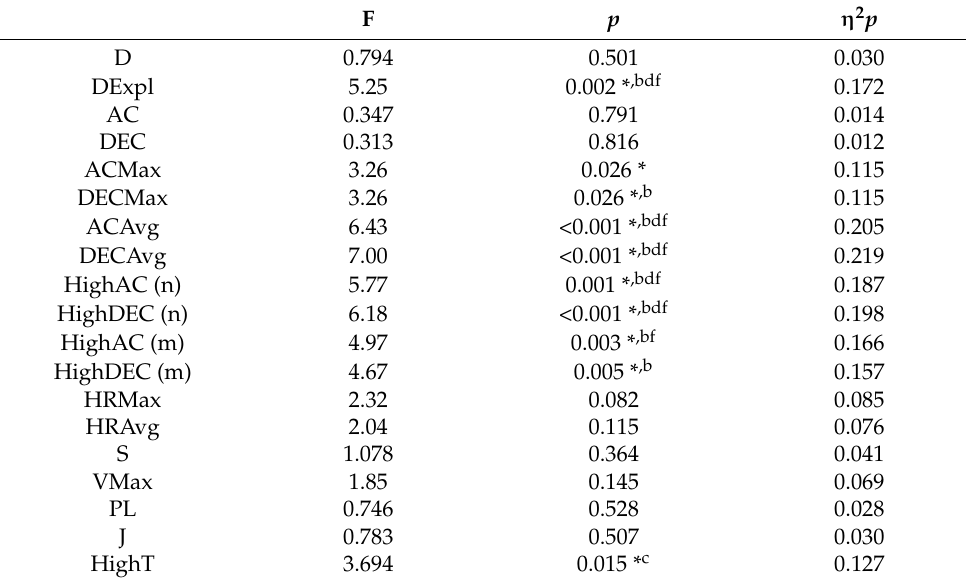
Table 4. Significant differences among the phases of the